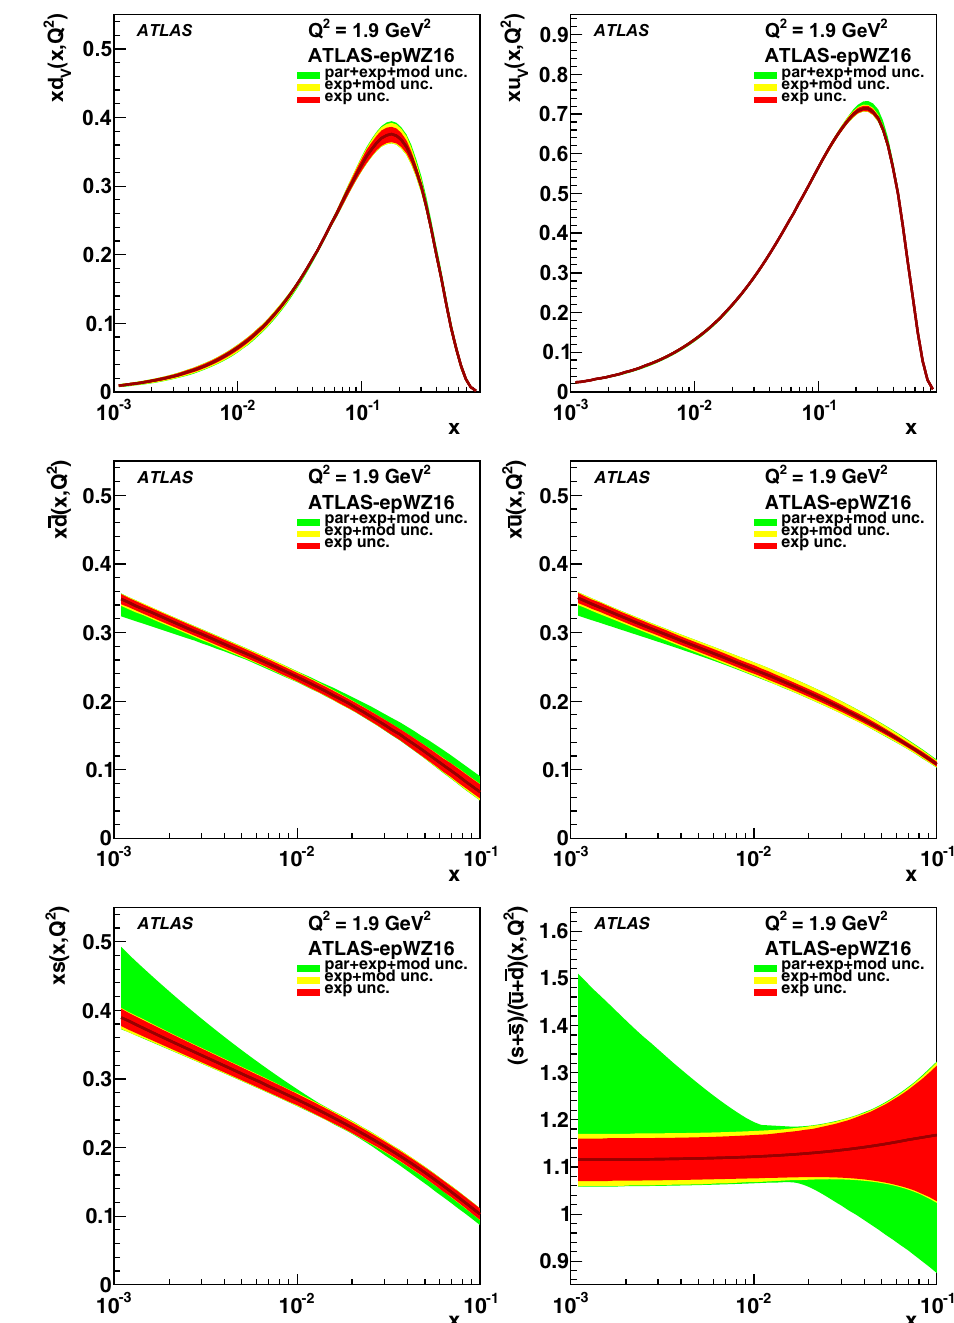
Fig. 30 PDFs from the present ATLAS-epWZ16 determination at the ( mod ) and parameterization ( par ) components in red , yellow and green , = 1 . 9GeV 2 . Top valence PDFs xd ( x ) , xu ( x ) ; mid- starting scale Q 2 respectively. The PDFs are shown in the region of maximum sensitivity v v 0 of the ATLAS W and Z /γ ∗ data, 10 − 3 < x < 10 − 1 , except for the dle light sea PDFs x ¯ d ( x ) , x ¯ u ( x ) ; bottom strange-quark distribution and valence ratio R s ( x ) . Uncertainty bands represent the experimental ( exp ), model